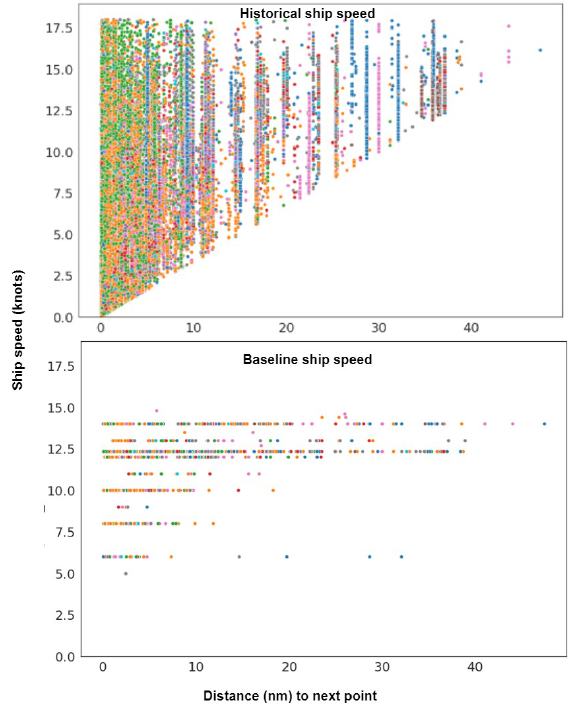
Figure 1. Visualization of the baseline speed and the actual speed per distance between two consecu- tive trajectory